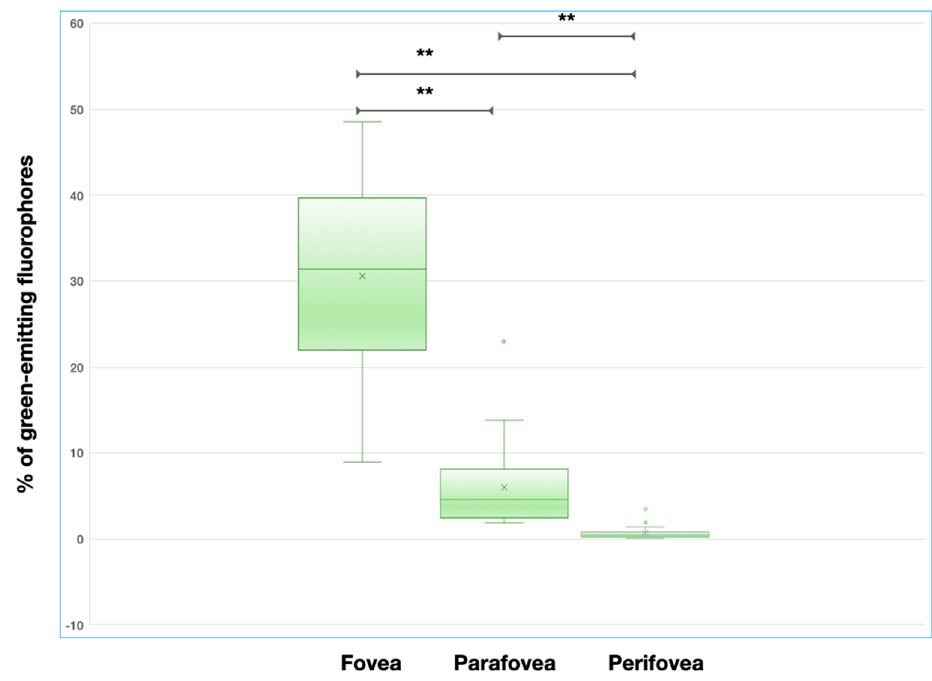
Figure 2. Box and whisker plots showing measurements of the area occupied by green-emitting fluorophores in di ff erent analyzed regions. Each box shows median (central horizontal line), mean (“x” in the box) and interquartile range (horizontal extremes of the box) values for each variable. The ends of the whiskers represent the minimum and maximum values. Dots not included in whiskers represent outliers. Horizontal black lines marked with two asterisks indicate statistically significant di ff erences between groups ( p < 0.0001).